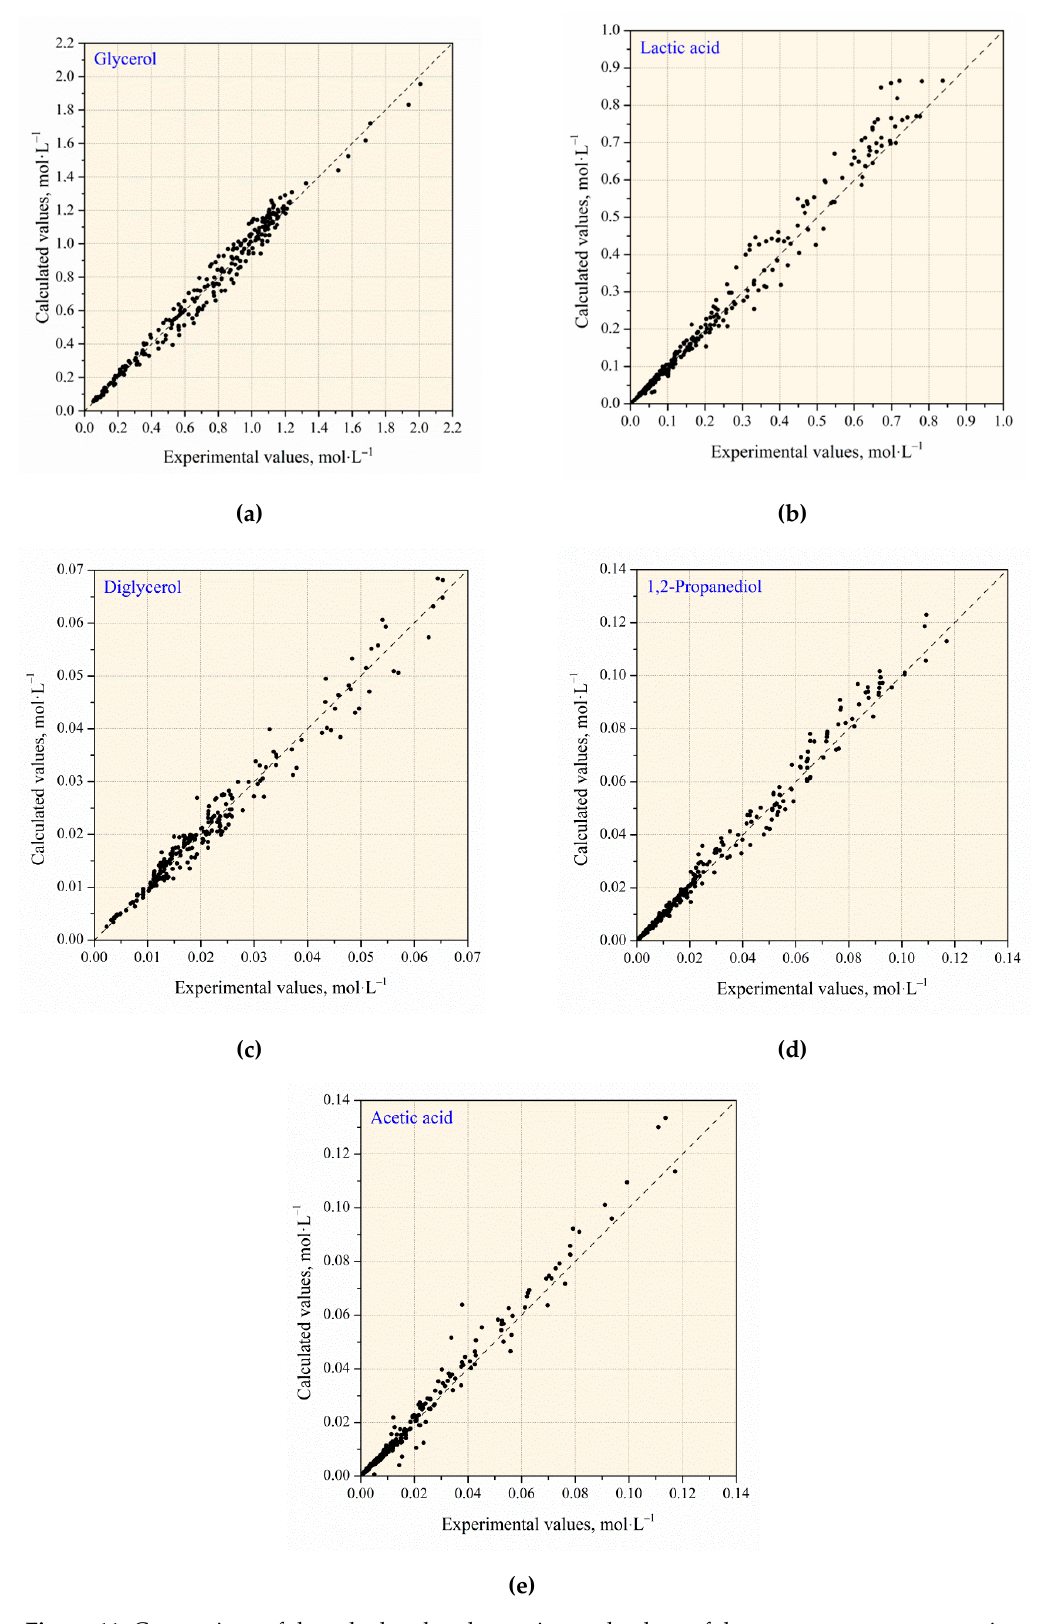
Figure 11. Comparison of the calculated and experimental values of the components concentration: ( a ) glycerol; ( b ) lactic acid; ( c ) diglycerol; ( d ) 1,2–propanediol; ( e ) acetic